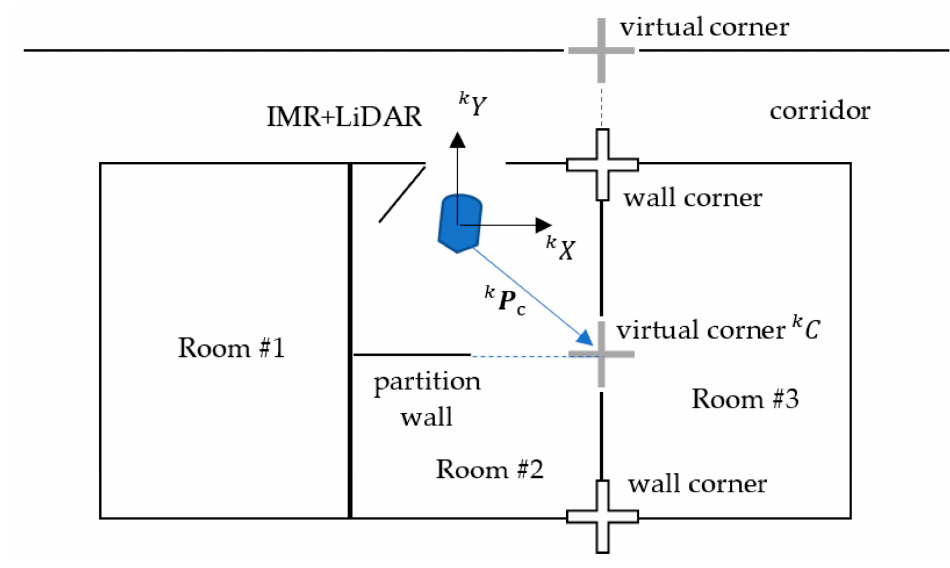
Figure 6. Wall corners, virtual corners and the most significant corner (MSC) k C